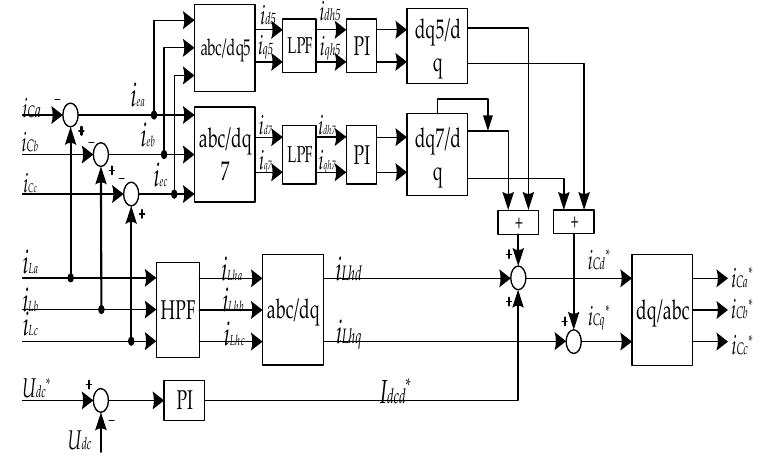
Figure 10. Compensation current command generation unit.